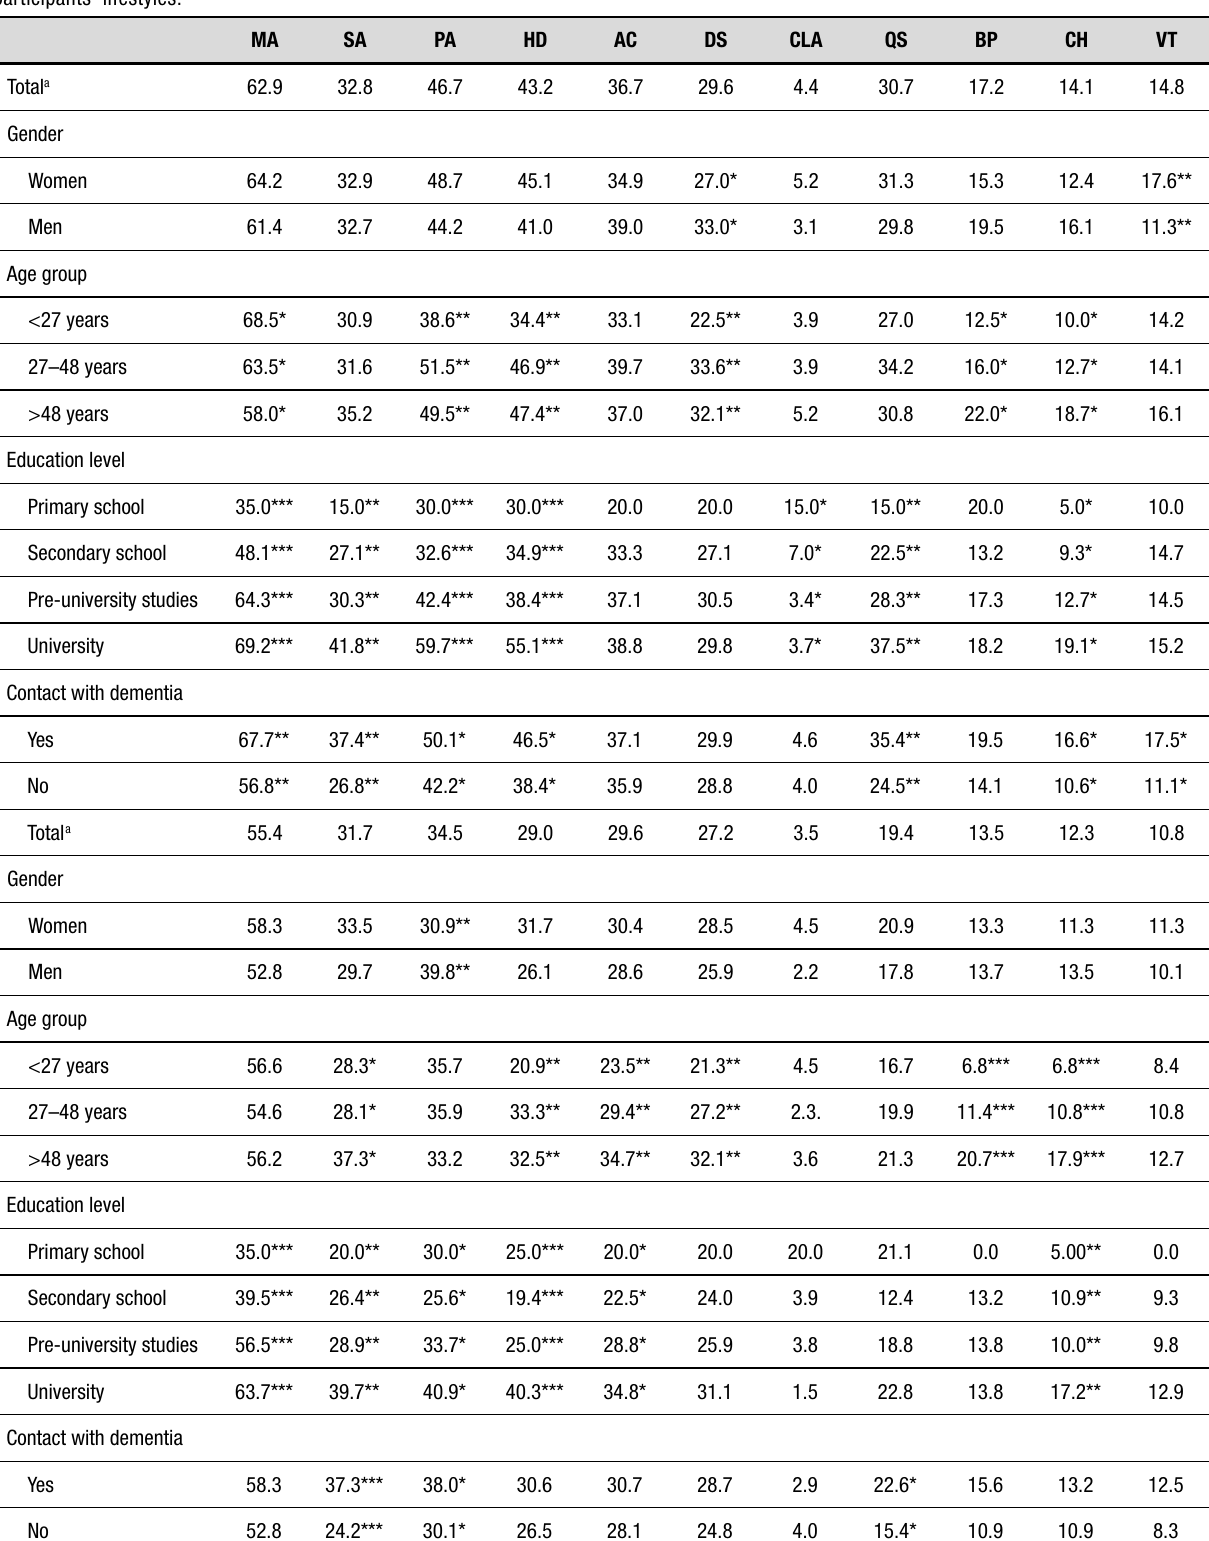
Table 3. Knowledge of behaviors that are beneficial for dementia risk reduction and dementia risk reduction behaviors incorporated into participants’